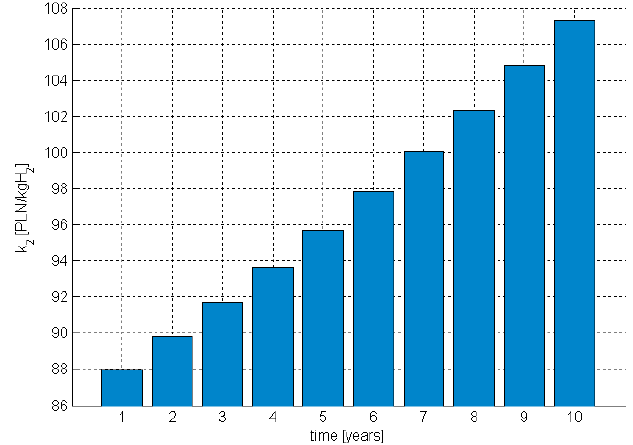
Figure 12. Change in the value of decision criterion k 2 for V3—own study.